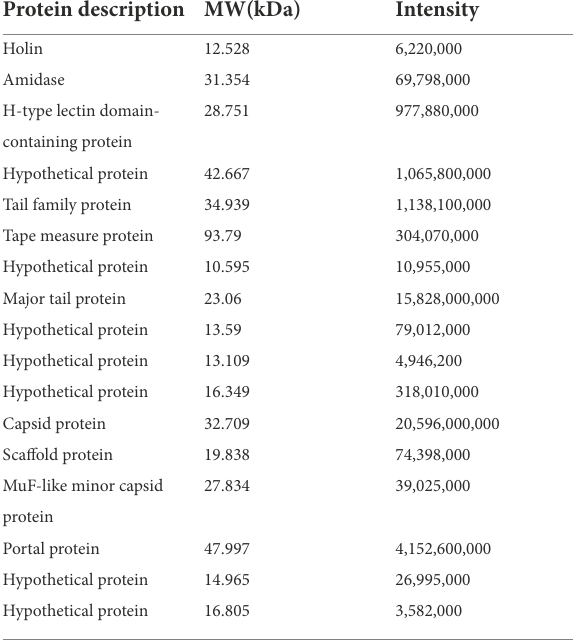
TABLE 5 Protein mass spectrometry of φ PaP11-13.